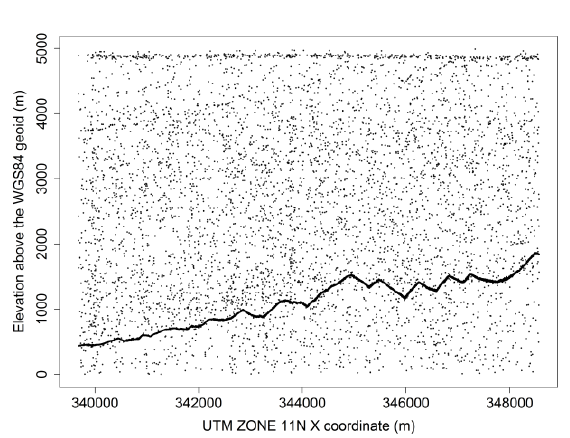
Figure 2. Transect 5’s raw data